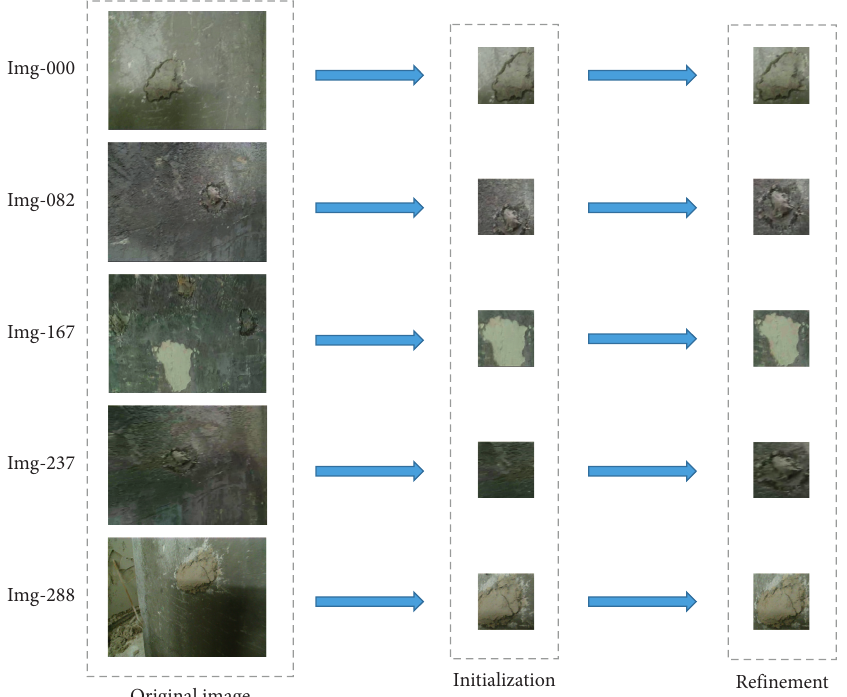
Figure 7: The qualitative experimental results. The initialization images and the refinement images are the output of the initialization module and refinement module,